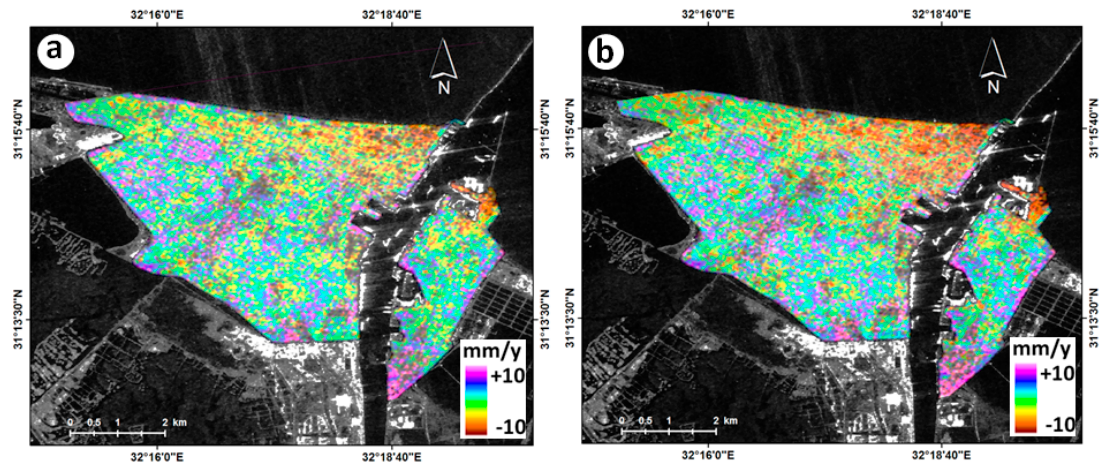
Figure 10. The velocity maps: ( a ) before; and ( b ) after the atmospheric artifacts filtering was applied during the second estimation of the displacement. A strong displacement (brown) and the uplift (purple) can be noted here. These displacement maps were improved significantly compared to the obtained maps using the first estimation.